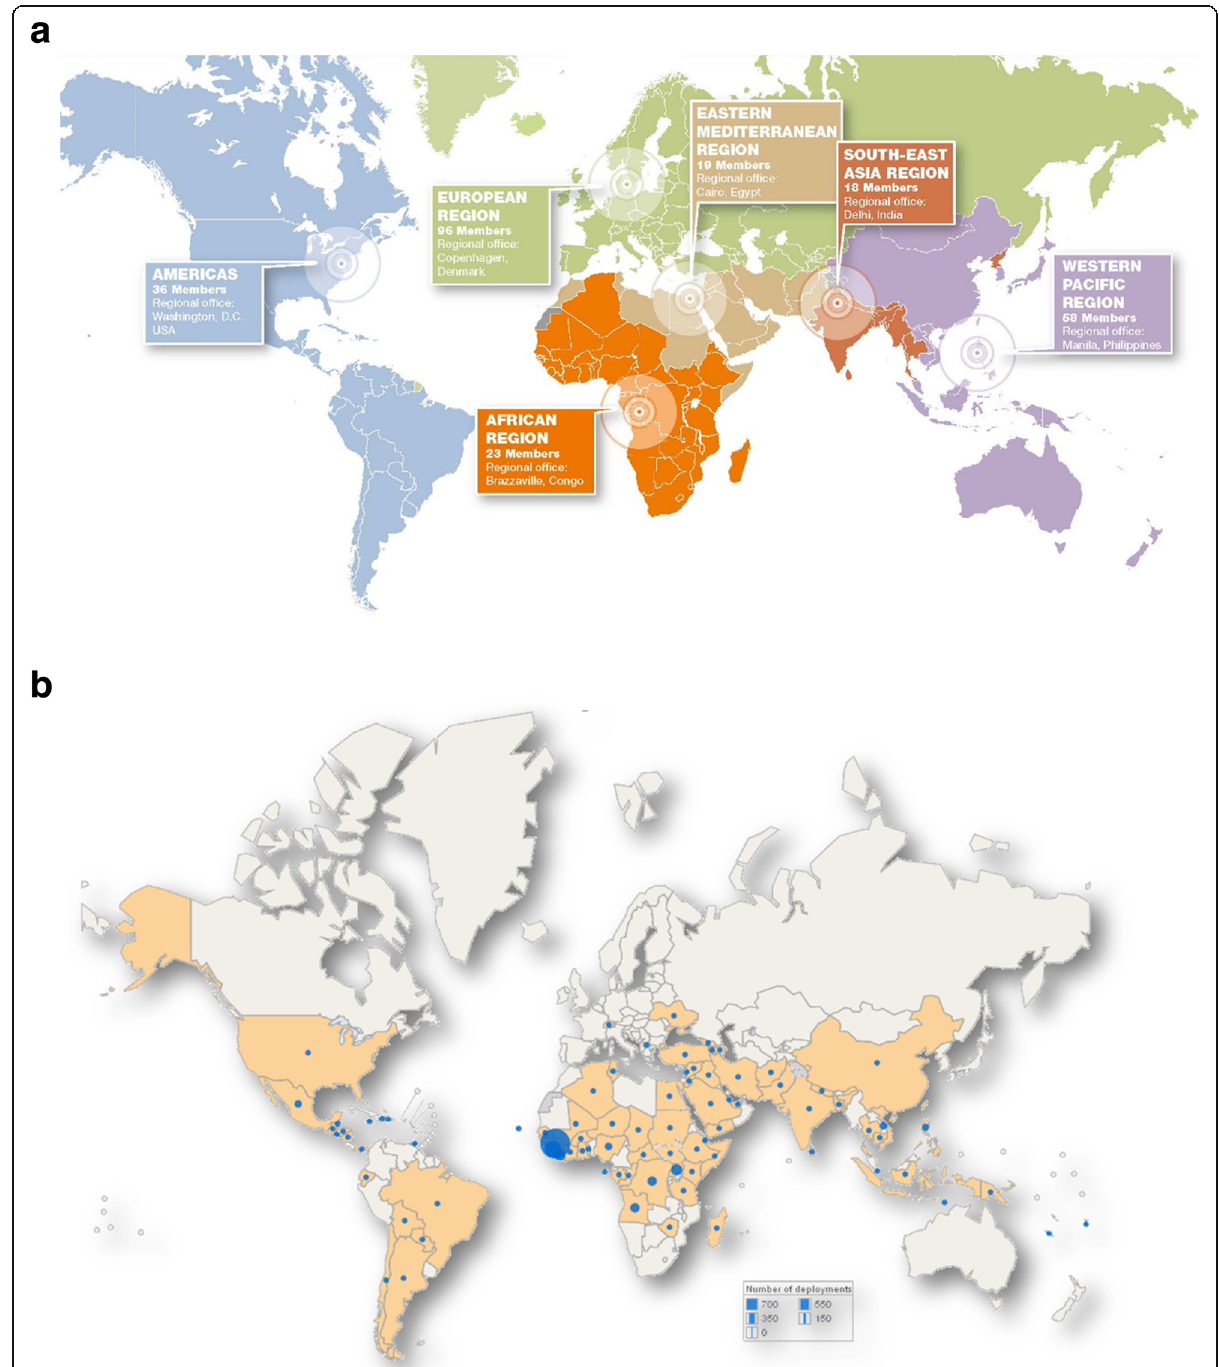
Fig. 1 a and b Between 2000 and 2018, GOARN deployed 134 field missions in 87 countries. This translates to approximately 2787 field deployments or 82,359 person-days in the